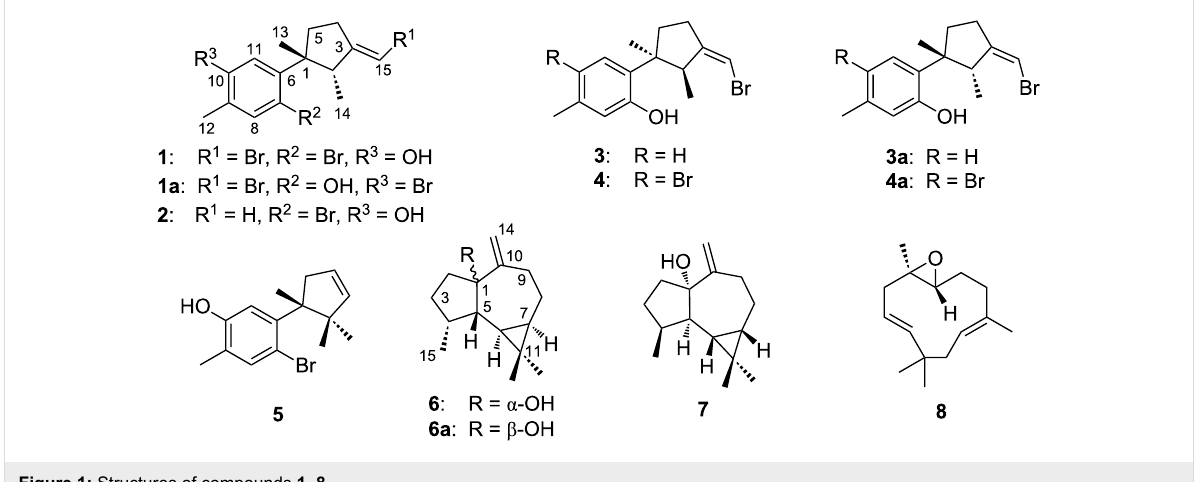
Figure 1: Structures of compounds 1 – 8